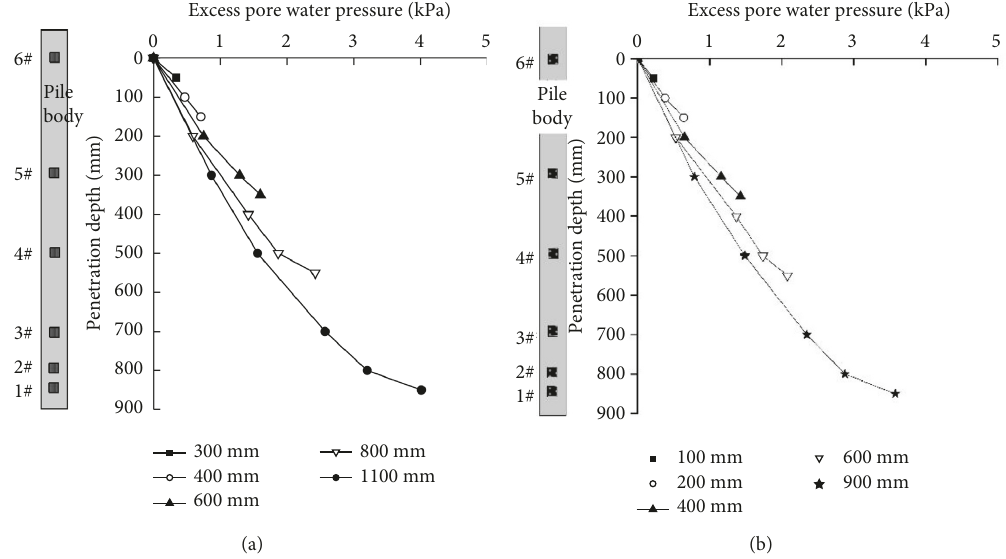
Figure 4: Excess pore water pressure distribution diagram for test piles TP1 and TP2 during the sinking process: (a) TP1, (b)